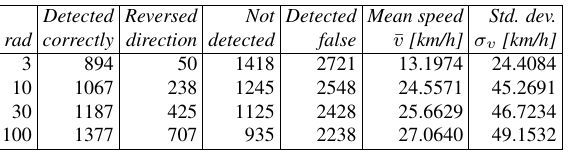
Table 5: Accuracy assessment of detected speeds in the WorldView-2 scene